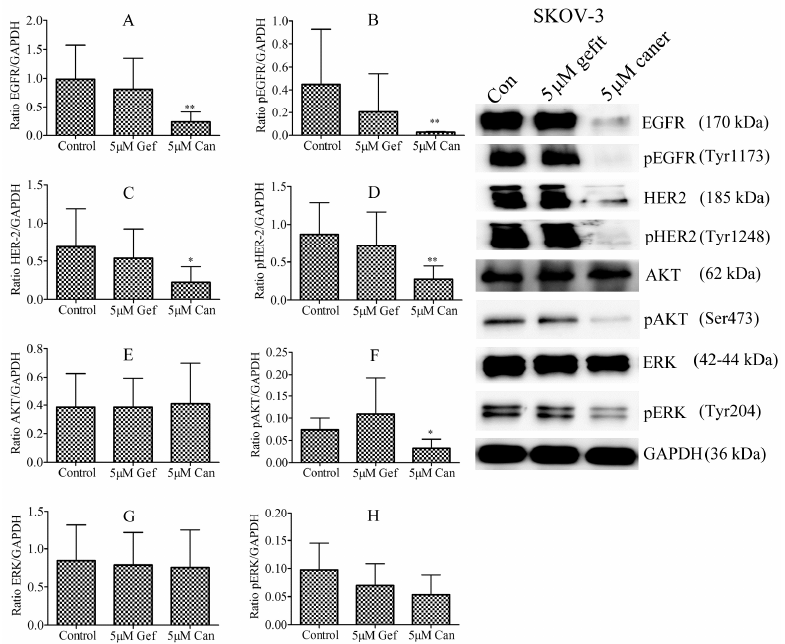
Figure 2. The e ff ect of gefitinib and canertinib on the total protein level and phosphorylation of EGFR, HER-2, AKT, and ERK in SKOV-3 cell aggregates, as shown by densitometry and Western blot. Canertinib, but not gefitinib, significantly reduced both EGFR ( A ), pEGFR ( B ), HER-2 ( C ), and pHER-2 ( D ). Total expression of AKT was not changed by both inhibitors ( E ). Only canertinib significantly reduced pAKT ( F ). The levels ERK and pERK do not significantly change in any treatment ( G , H ). Representative analysis from a set of five independent experiments (Mean ± SE; n = 5) is presented, and statistical significance was determined by a t -test ( * , p < 0.05, **, p < 0.01).